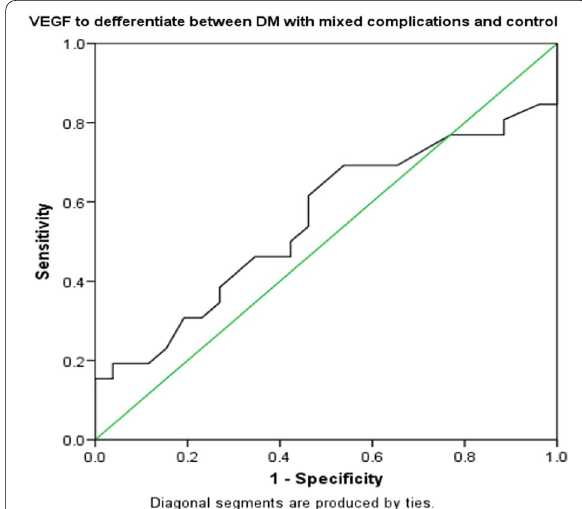
Fig. 4 ROC curve analysis of VEGF‑A for prediction of mixed diabetic